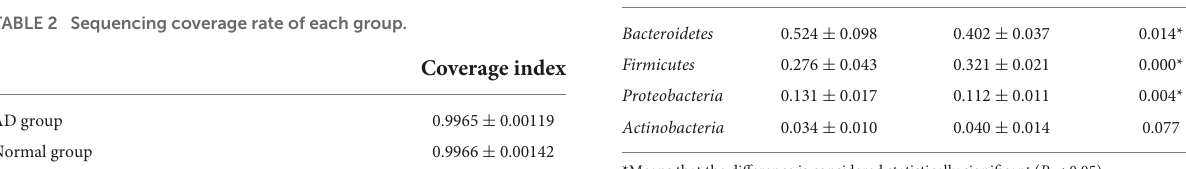
TABLE 2 Sequencing coverage rate of each group.